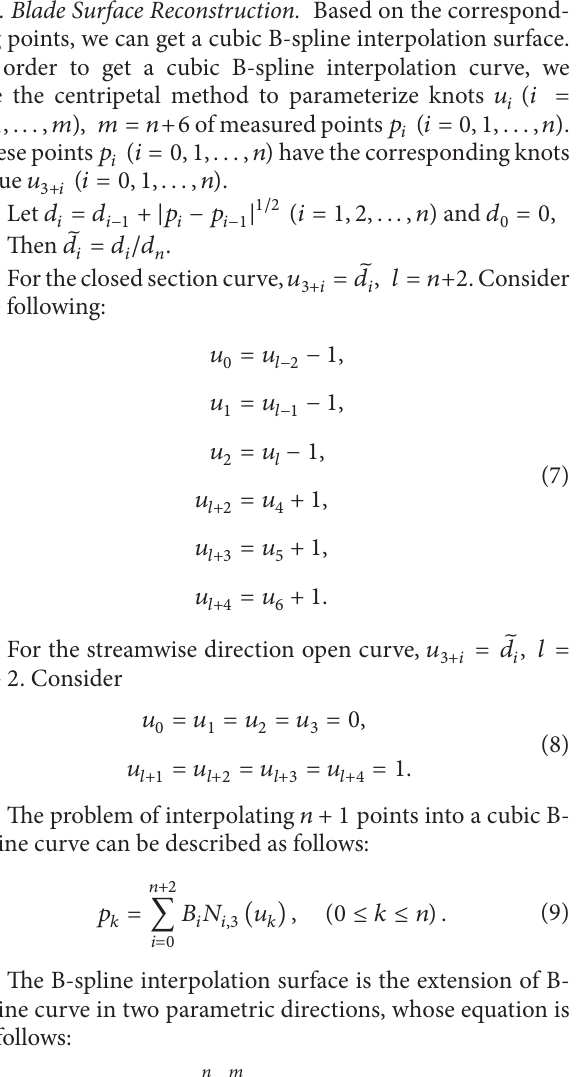
Figure 6: The measuring equipment.